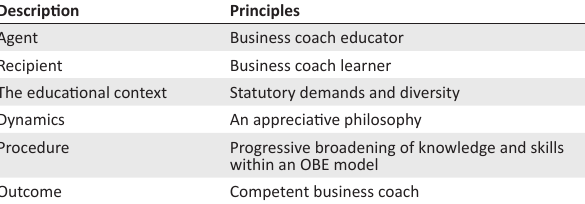
TABLE 1: Organising principles of Dickoff, James, and Wiedenbach